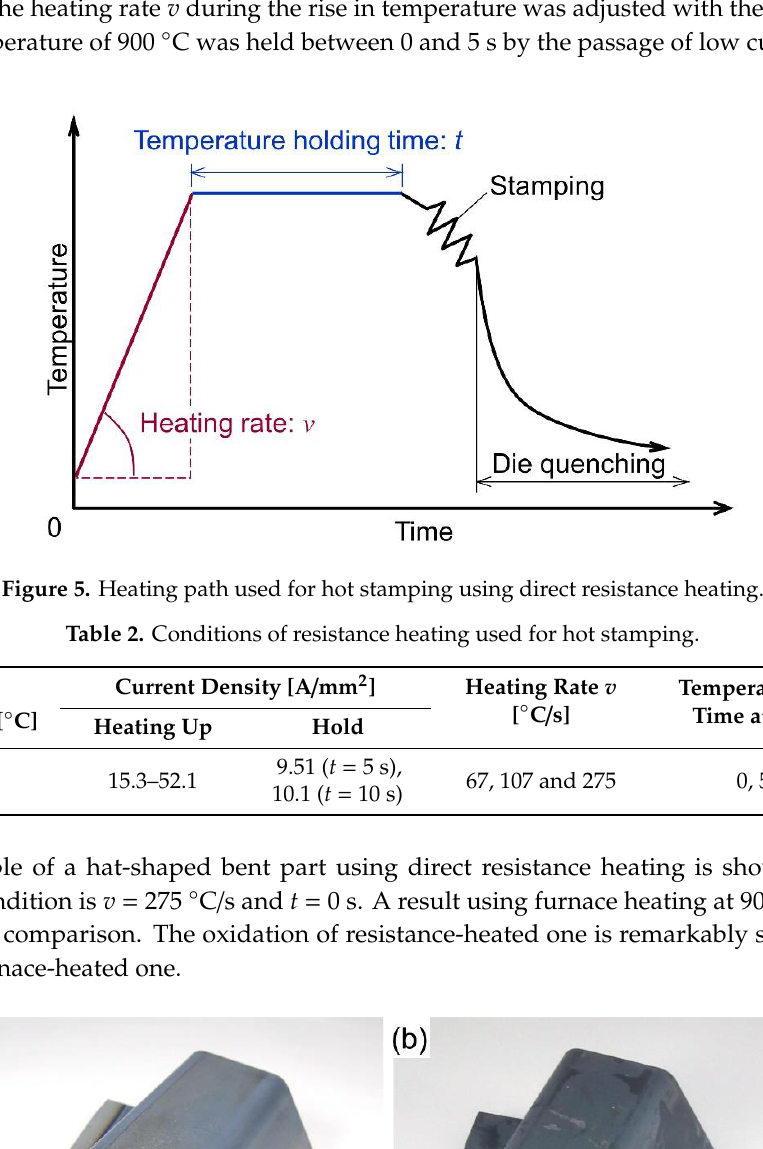
Table 1. Conditions used for hot stamping of hat-shaped bending.